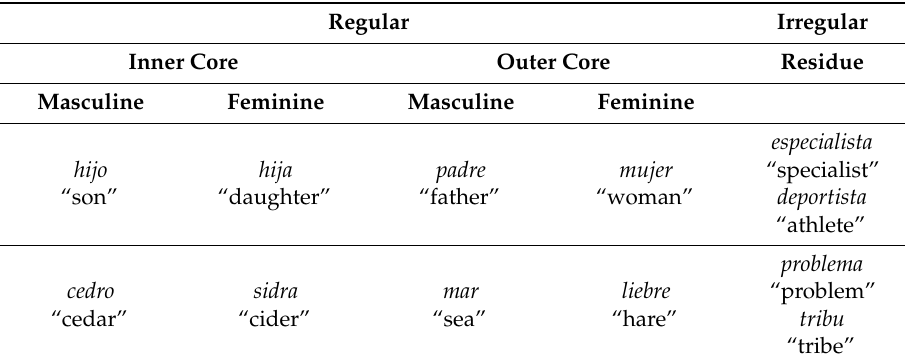
Table 1. Spanish gender morphological